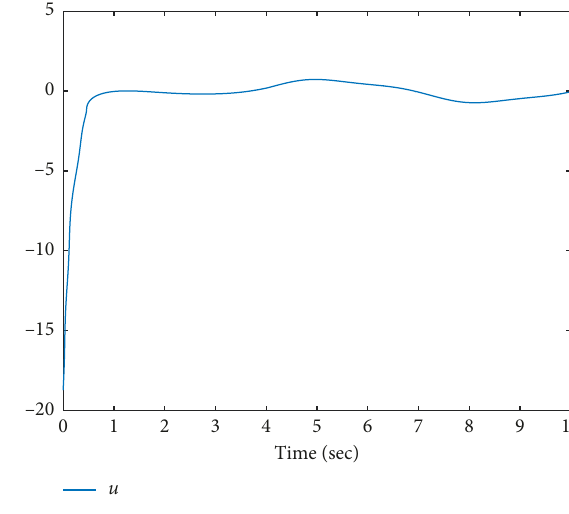
Figure 15: State of the